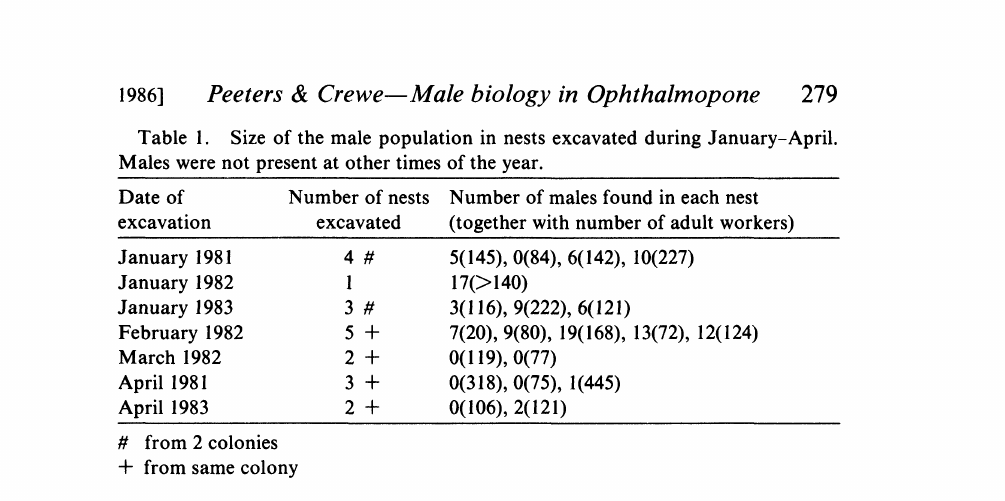
Table 1. Size of the male population in nests excavated during January-April. Males were not present at other times of the year. Date of Number of nests Number of males found in each nest excavated (together with number of adult excavation